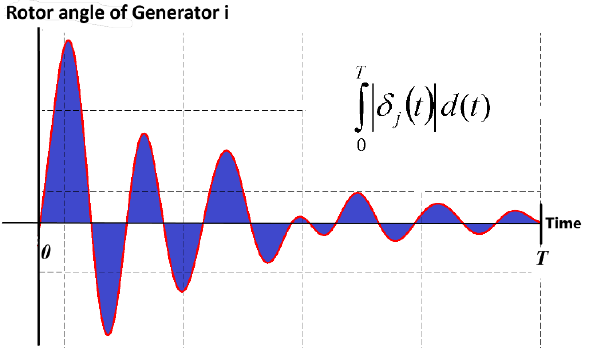
Figure 4. The δ oscillation curve of a generator at time interval of (0 − T ) and its corresponding area .